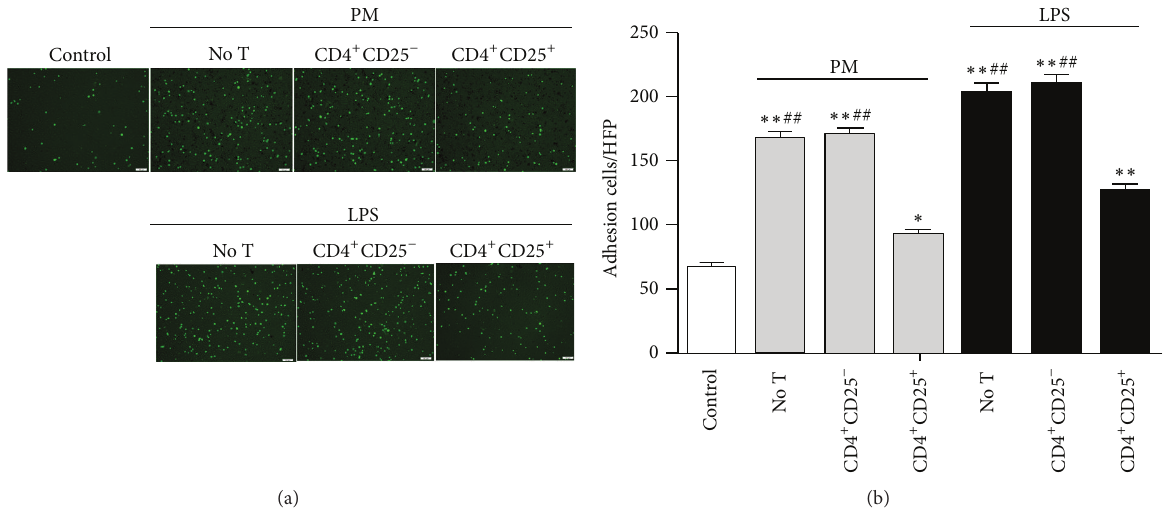
Figure 6: Tregs decrease the adhesion of THP-1 cells to endothelial cells. (a) Representative photomicrograph of THP-1 cells adhering to endothelial cells (ECs). THP-1 cells were identified by green fluorescence. Scale bar = 100 nm. (b) The adhesion of THP-1 cells to ECs was determined by fluorescence microscopy. Data are expressed as means ± SEM. ∗ indicates no T, CD4 + CD25 − , or CD4 + CD25 + versus control; # indicates no T or CD4 + CD25 − versus CD4 + CD25 + . ∗ 𝑃 < 0.05 , ∗∗ 𝑃 < 0.01 , and ## 𝑃 < 0.01 . Experiments were repeated 4 times.